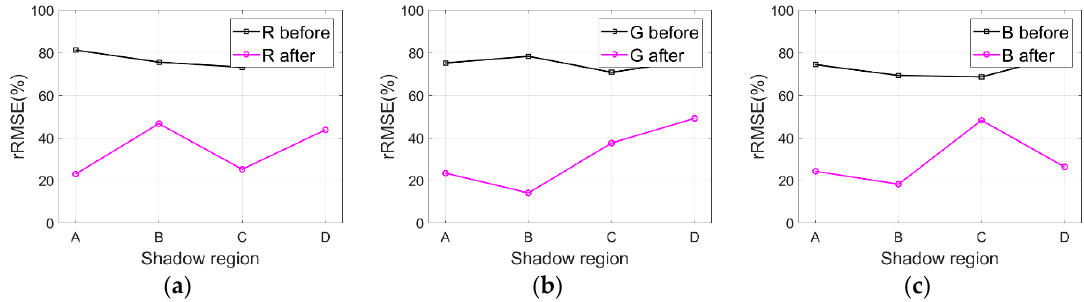
Figure 14. rRMSE of various shadow areas of images compensated before and after by the IRB approach for the test image Tripoli-1 in terms of R, G, and B components. ( a ) R. ( b ) G. ( c ) B .